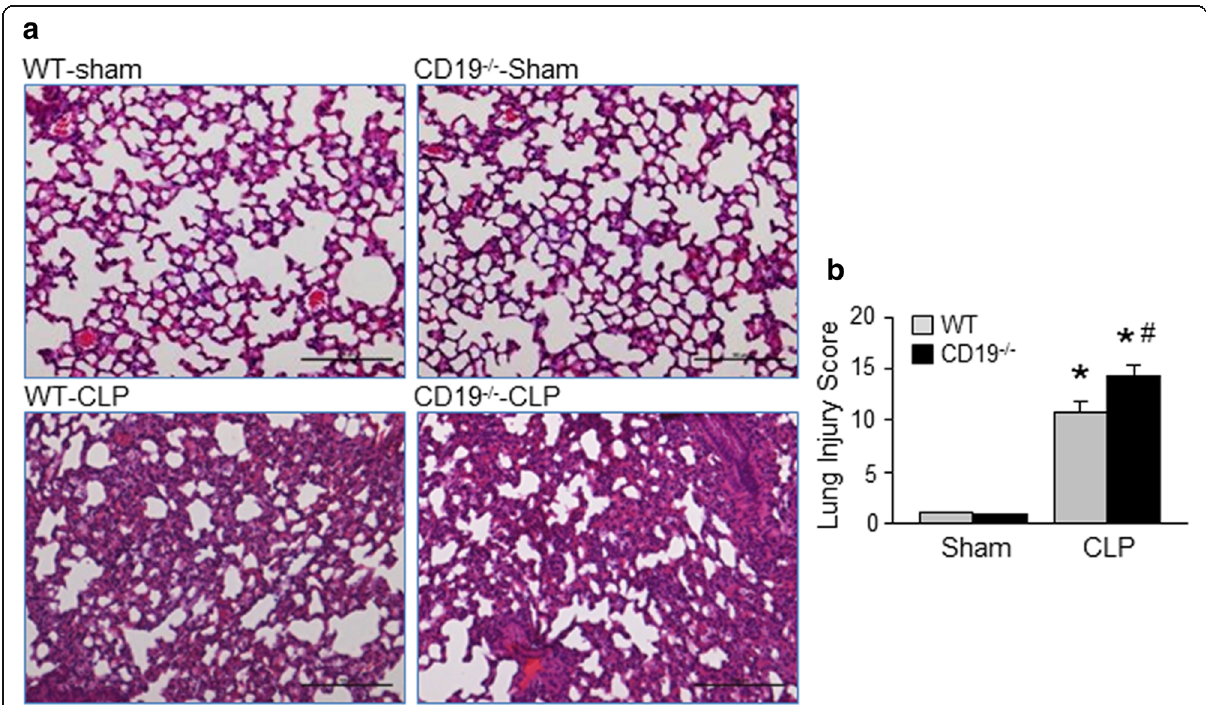
Fig. 6 Deficiency of B-1a cells exaggerates lung injury during sepsis. a After 20 h of CLP induced in WT and CD19 − / − mice, lung tissues were harvested and stained with H&E. The slides were observed under light microscopy at × 100 original magnification in a blinded fashion. Representative images for each group are shown. Scale bar, 100 μ m. b Histological injury scores of the lungs in WT and CD19 − / − mice were quantified as described in Materials and Methods. Data obtained from three independent experiments are expressed as means± SE ( n = 6 mice/ group) and compared by one-way ANOVA and SNK method ( * p < 0.05 vs. shams; # p < 0.05 vs. WT CLP mice). CLP, cecal ligation and puncture; H&E, hematoxylin and eosin